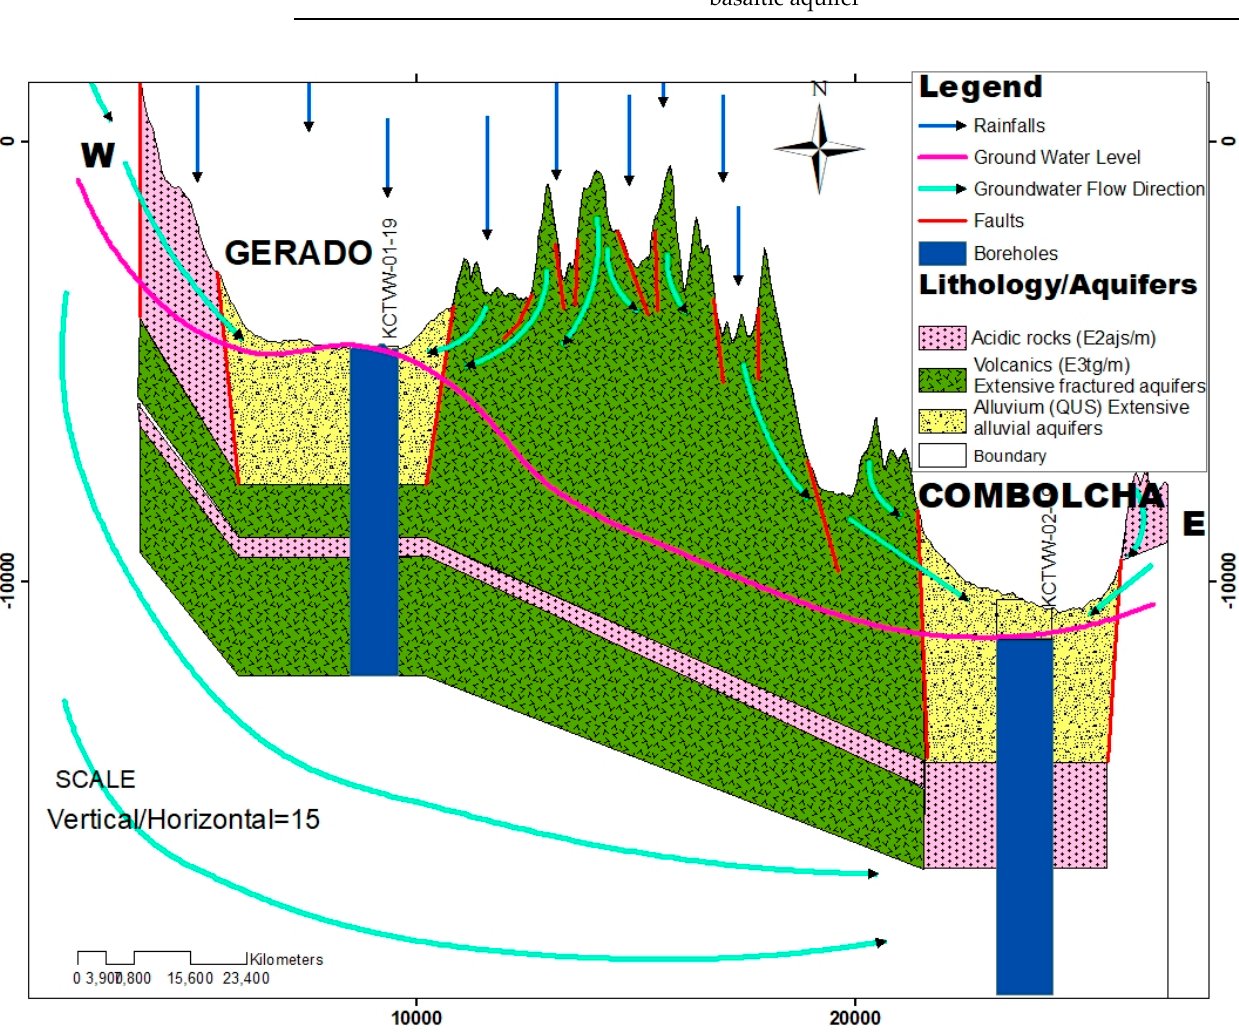
Figure 4. Gerado–Combolcha cross-section showing the regional and local groundwater flow pro- duced.